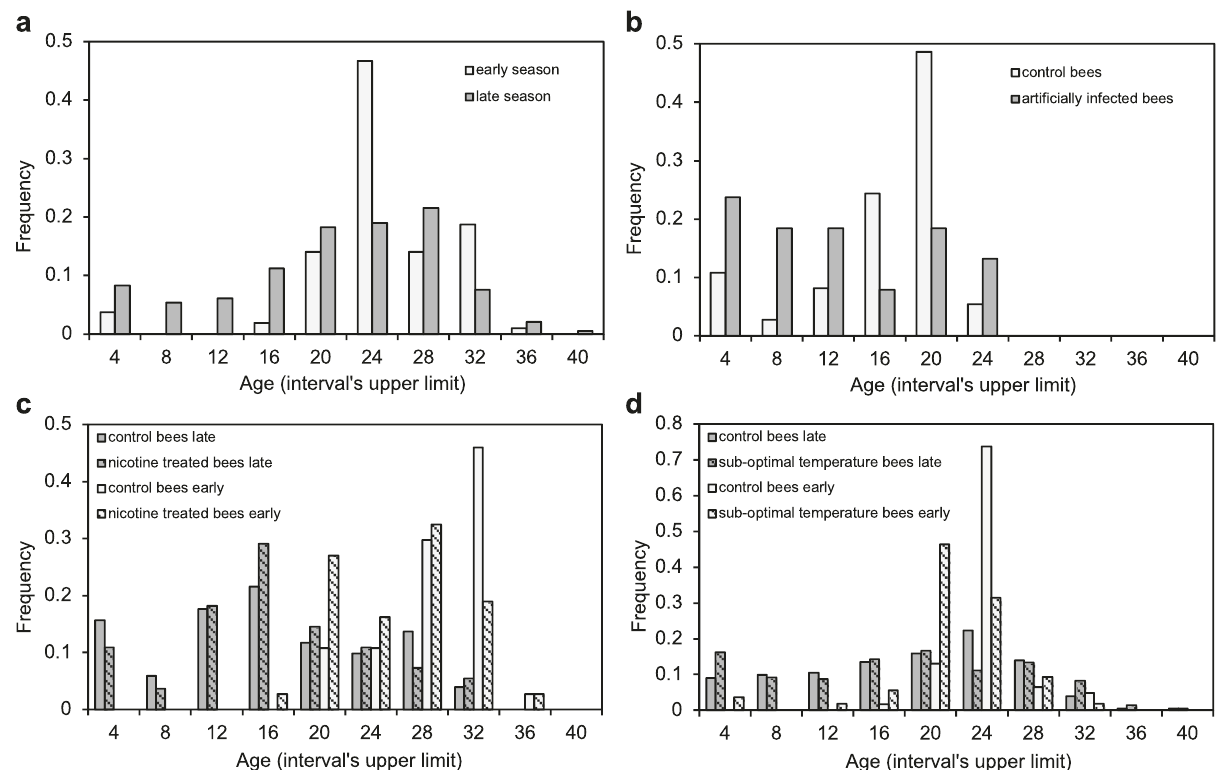
Fig. 3 | Distribution of individual lifespans of honey bees under different con- ditions.a Earlyintheseasonwhentheprevalenceofanimmune-suppressingvirus islow(whitebars)andlaterwhenallbeesarevirusinfected(graybars). b Treatedor not (gray and white bars, respectively) with a virus administered to mature larvae throughthediet. c Whenexposedtoatoxiccompound,whentheprevalenceofan immune-suppressing virus is low (white bars with diagonal pattern) or when the